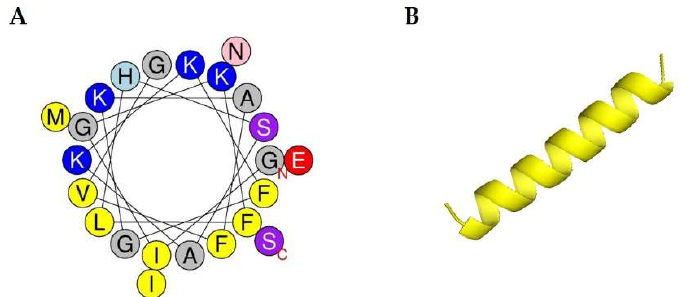
Figure 1. Structure analysis of magainin 2. ( A ) Helical wheel diagram of the peptide. The projection was obtained from http://heliquest.ipmc.cnrs.fr/cgibn/ComputParam.py. Positively charged residues are represented in blue, while hydrophobic residues are shown as yellow circles. The N-terminal and C-terminal parts are represented in red letters “N” and “C”. ( B ) Three-dimensional structure of magainin 2.